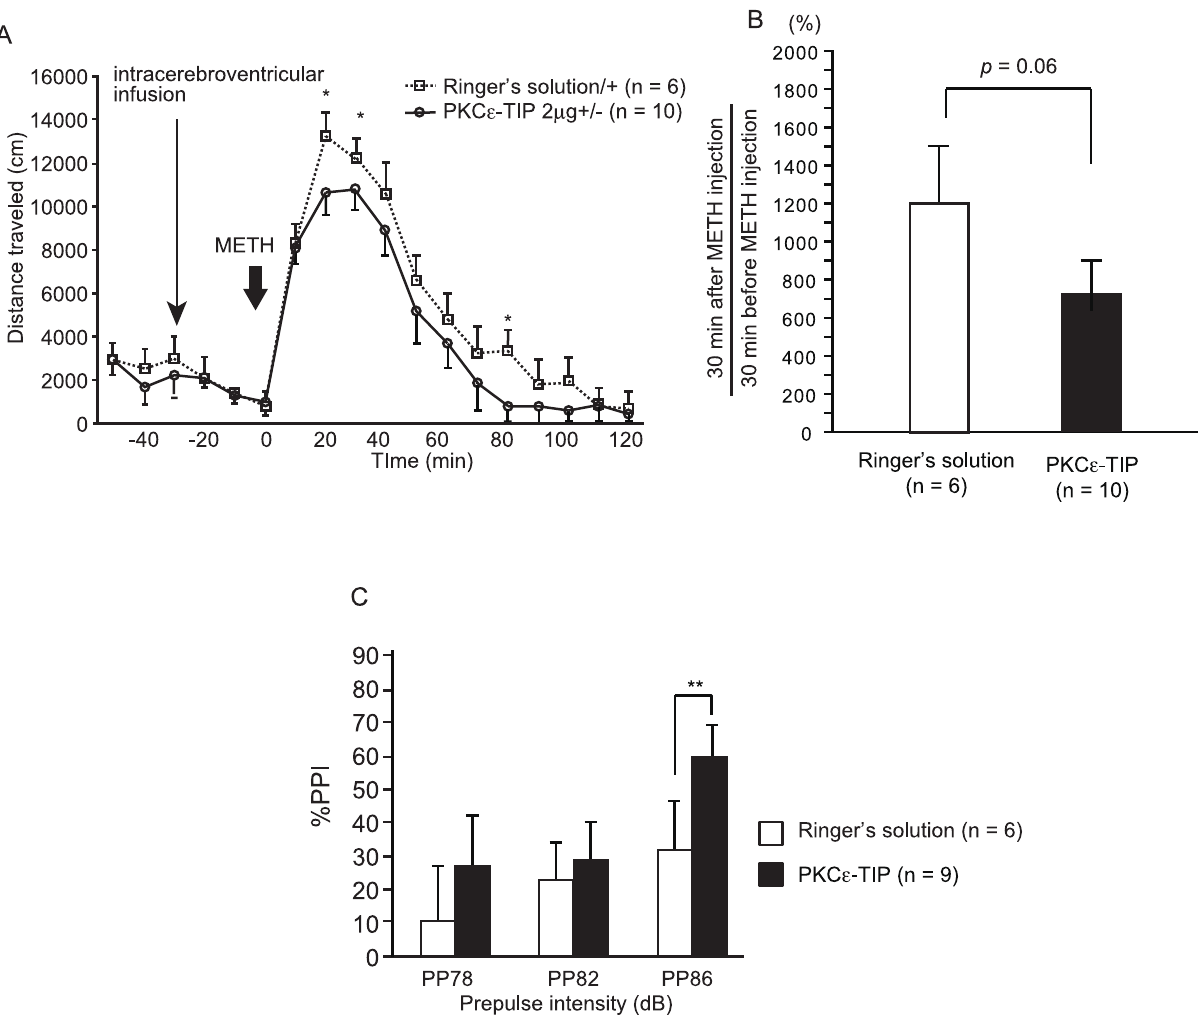
Figure 3. Effects of PKC e -TIP on locomotor activity and prepulse inhibition response to METH. Relative locomotor activity (A, B) and prepulse inhibition (C) by the treatment of PKC e -TIP after chronic METH administration. Values are shown as mean 6 SD. P values are based on ANOVA. * p , 0.05 and ** p , 0.01 by ANOVA.